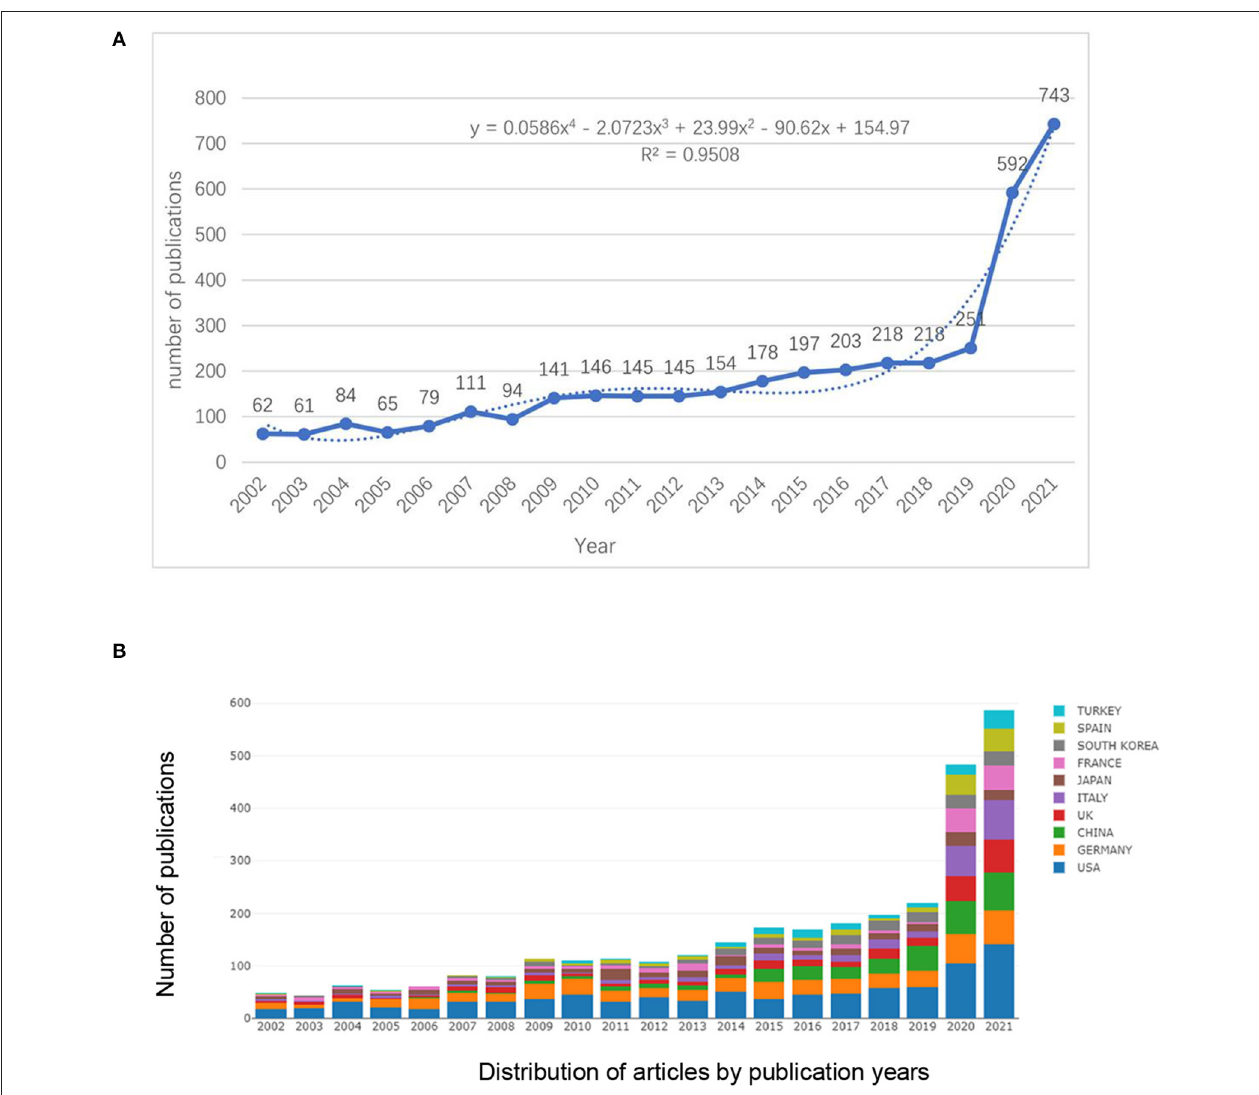
FIGURE 2 | The number and polynomial curve fitting of publications (A) and top 10 countries or regions publishing olfactory dysfunction research between 2002 and 2020 (B) .